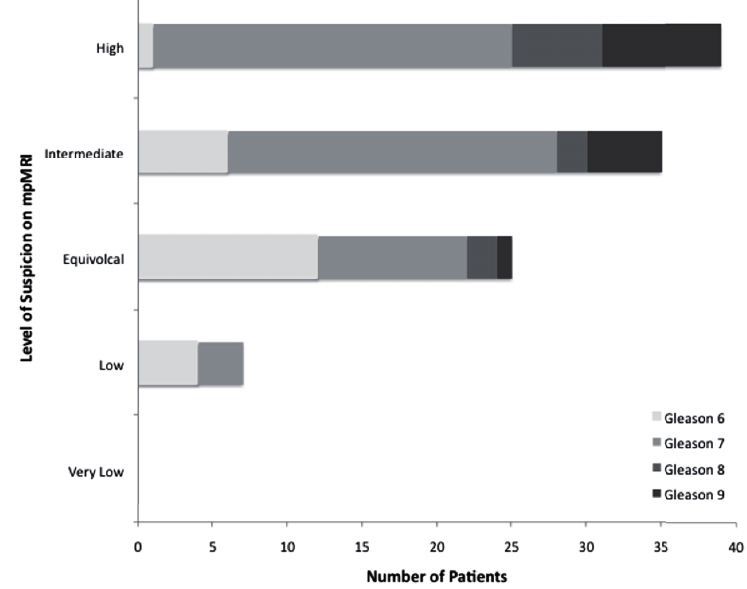
Figure 3 - Frequency of patients in each Gleason score value in correlation with level of suspicion on mpMRI